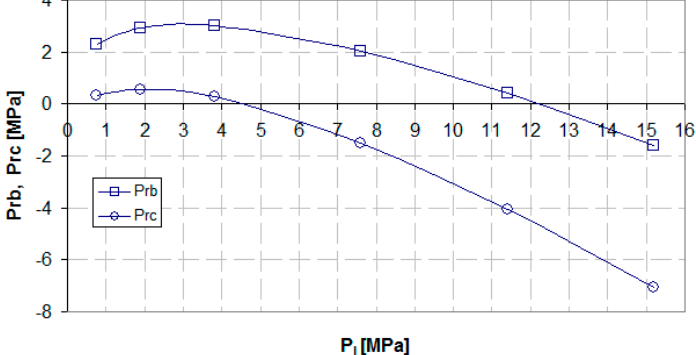
Figure 20. The variability in P rb and P rc as a function of the pressure P L for the coal from the Northern San Juan basin.